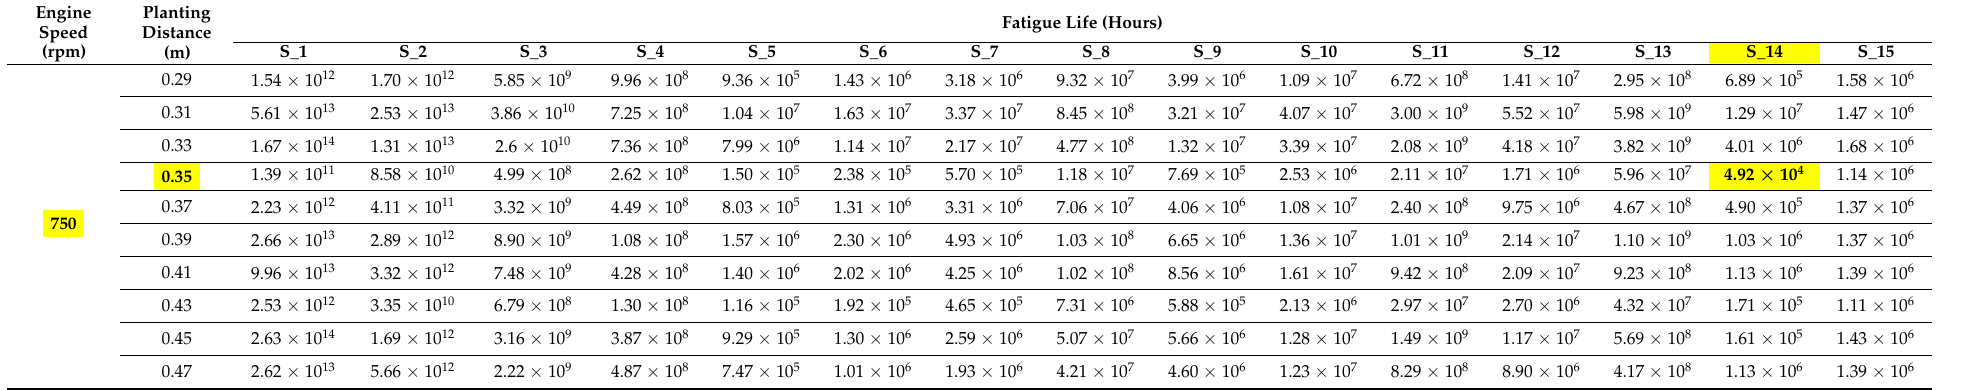
Table 2. Fatigue life in every spot of strain gauge under each working